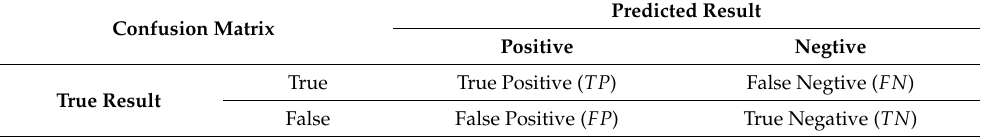
Table 2. The confusion matrix.